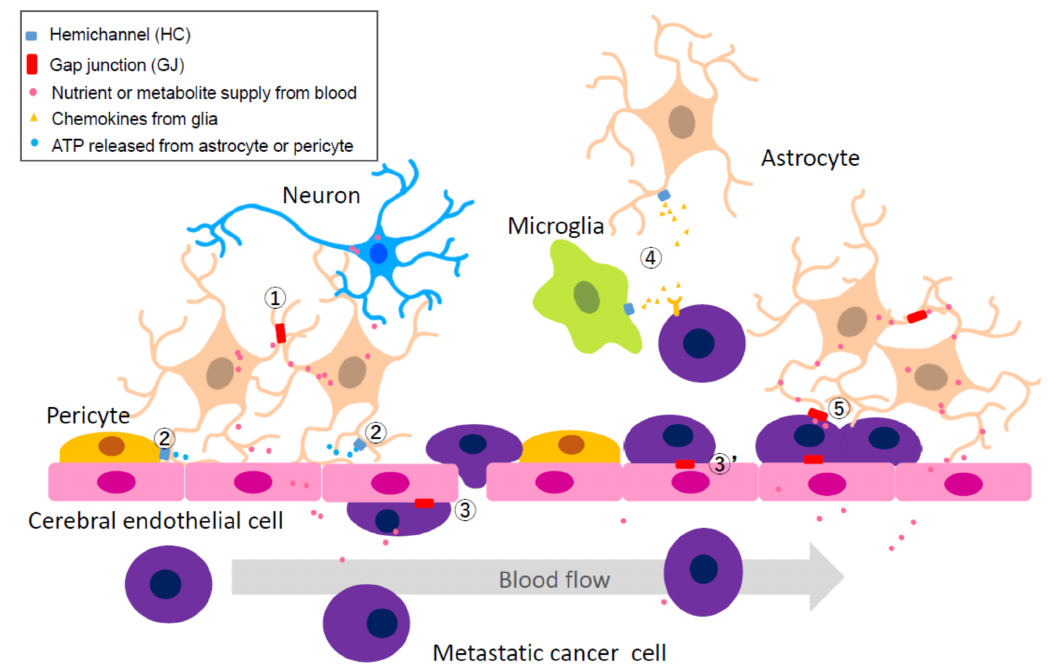
Figure 2. The peri-vascular niche of the tumor microenvironment highlighting the extravasation of metastatic cells. The neurovascular unit includes cerebral endothelial cells (CECs), pericytes, glial cells, and neurons. Metastatic cancer cells utilize the nutrient supply from CECs to CNS cells mediated by the astrocytes. Numbers in circle indicate specific communication pathways. Pathway 1 : GJ between normal astrocytes; it supports nutrients from CECs to CNS neurons. Pathway 2 : HC activity of astrocytes and pericytes; it adjusts [Ca 2+ ] i concentration in nearby CECs via release of ATP which results in change of blood flow rate. Pathway 3 : GJ between CEC and metastatic cancer cell inside the capillary; it supports extravascular liberation of cancer cell from blood vessels. Pathway 3 (cid:48) : GJ between CEC and metastatic cancer cell located in a pericyte-like location; it protects cancer cells from immune attack by CNS astrocyte and microglia. Pathway 4 : HC activity of microglia or astrocyte; it supports cancer growth by release of chemokines, although the actual mechanisms by which glial cells promote immune attack or support cancer remains unknown. Pathway 5 : GJ between metastatic cancer cell located in a pericyte like-location and an astrocyte; it contributes to cancer growth as the first step in brain